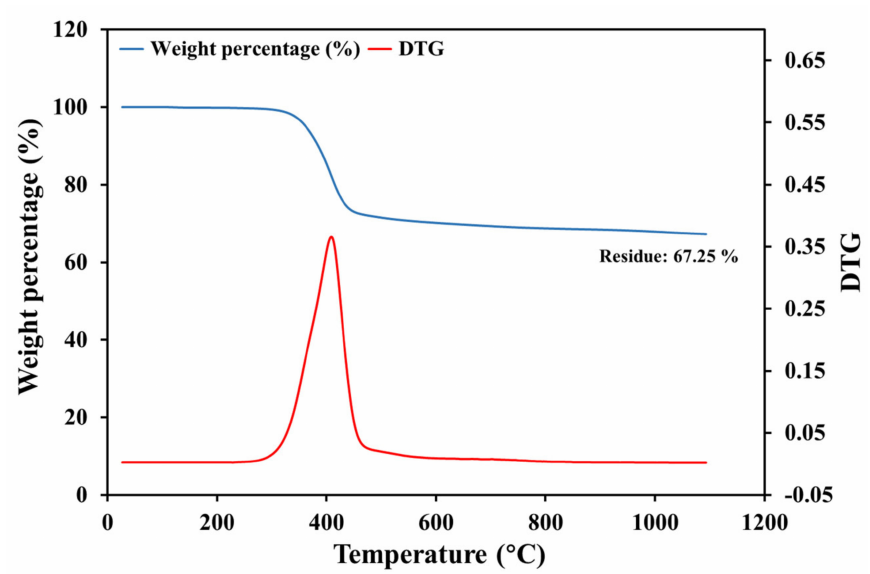
Figure 2. Thermogravimetric curves of CF/EP prepreg heated from room temperature to 1100 ◦ C in